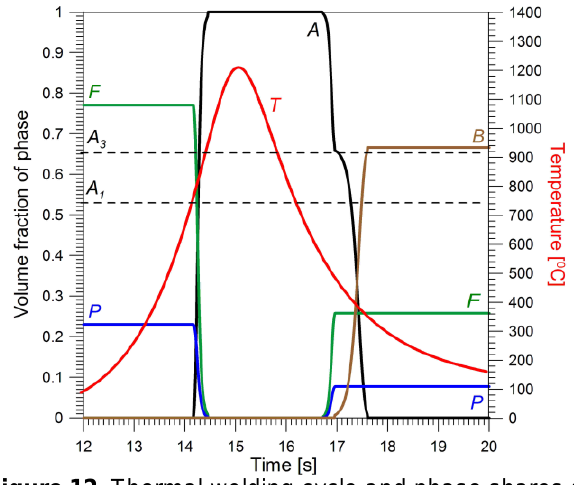
Figure 12. Thermal welding cycle and phase shares at point 2